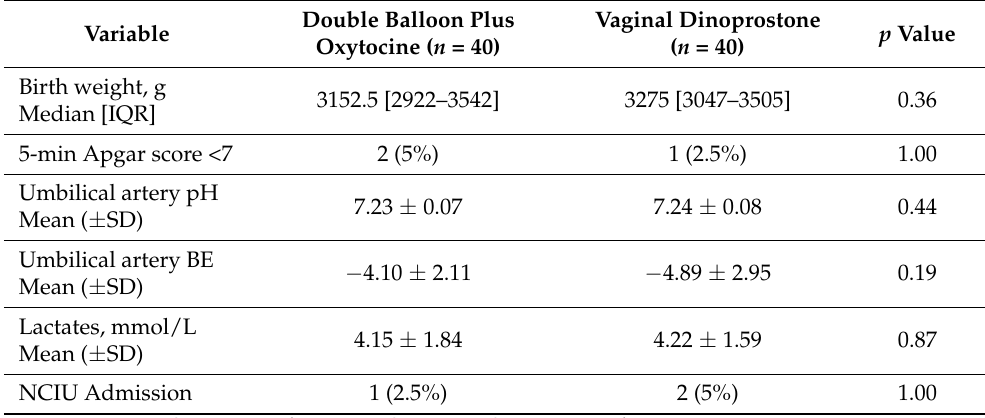
Table 4. Neonatal